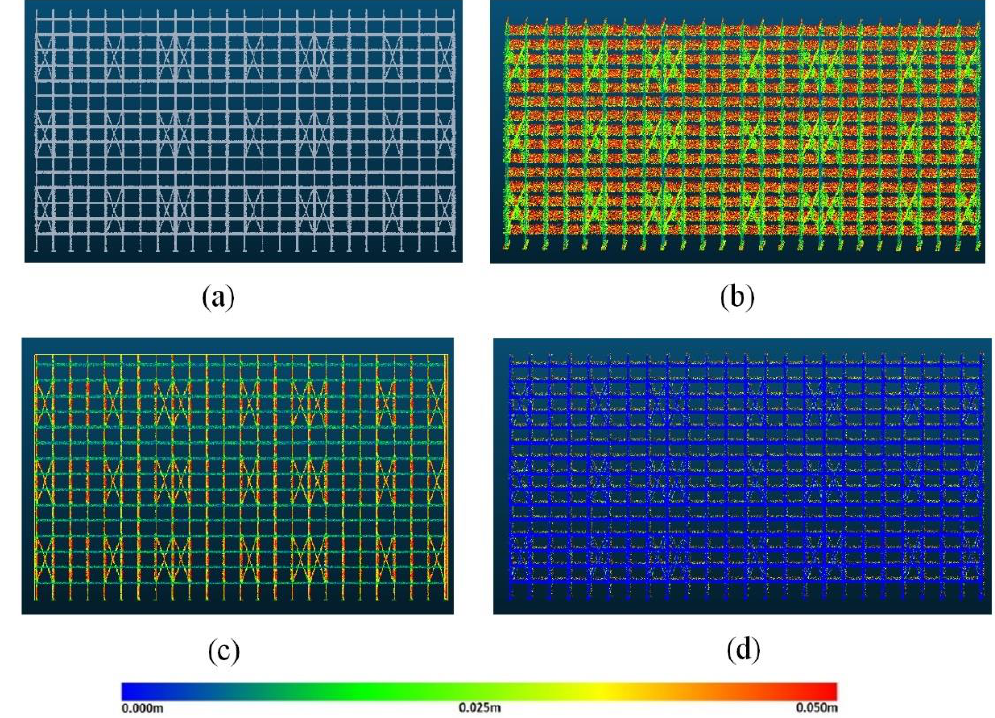
Figure 16. M3C2 deviations of all modelling methods vs. the reference TLS point cloud: ( a ) the ground truth TLS model, ( b ) the photogrammetry method, ( c ) the data fusion model 1, and ( d ) the data fusion model 2. The color scale for the M3C2 distance value is 0–5 cm. Table 7. Computing times for each model from pre-processed to textured mesh